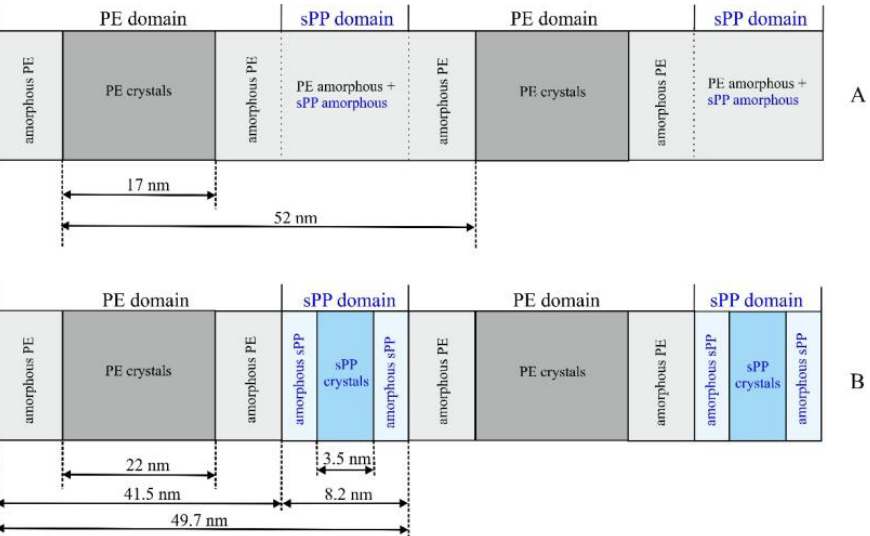
Figure 8. Models of the morphology of the sample PE-b-sPP-1 with f sPP = 53% that develops by crystallization upon cooling from the melt, at 125 – 130 °C when mainly PE crystals contribute ( A ), and at room temperature when both PE and sPP crystals are well-formed ( B ). The values of the thickness of the crystalline lamellae of PE and sPP and of the amorphous layers and of the perio- dicities, are indicated.